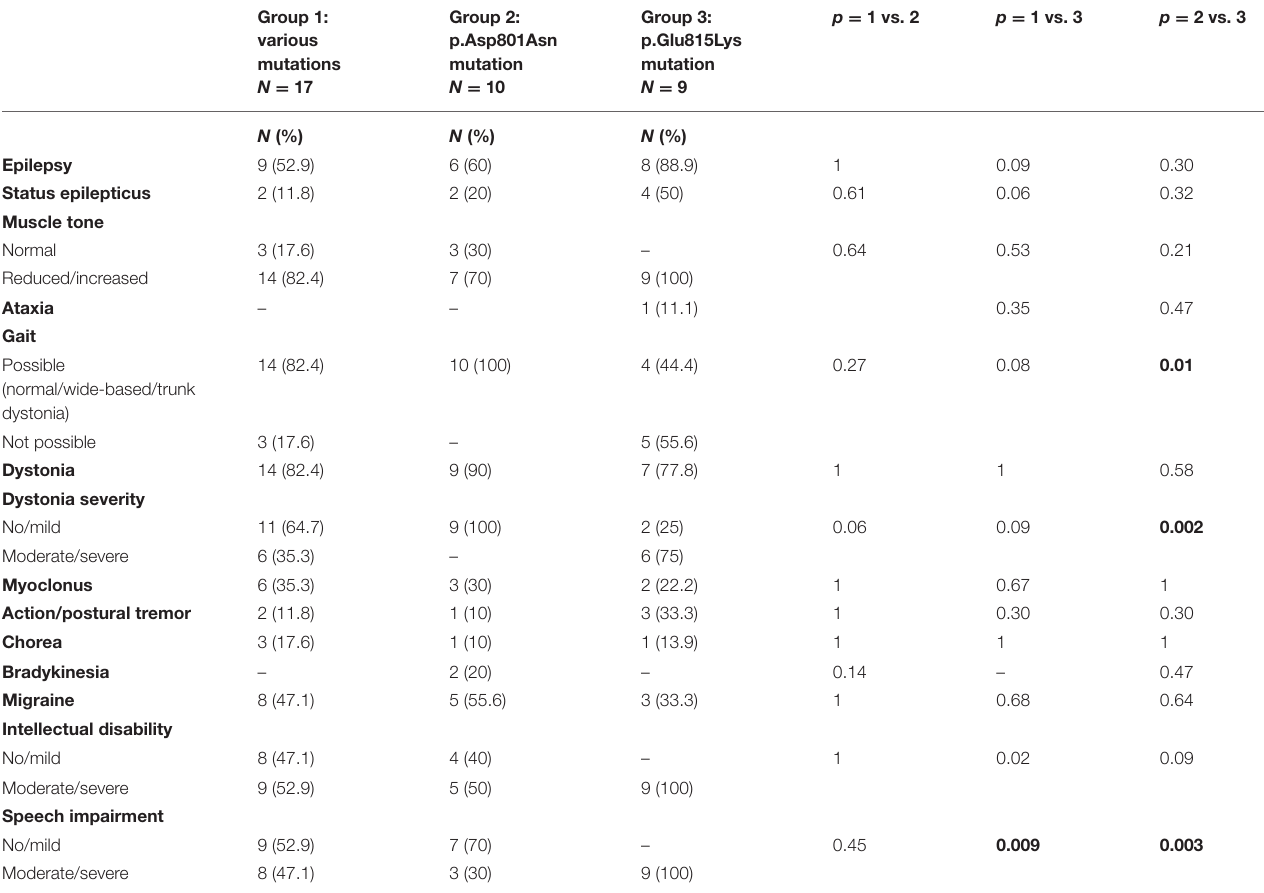
TABLE 2 | Epilepsy, non-paroxysmal movement disorders, and cognition in the three mutational groups.